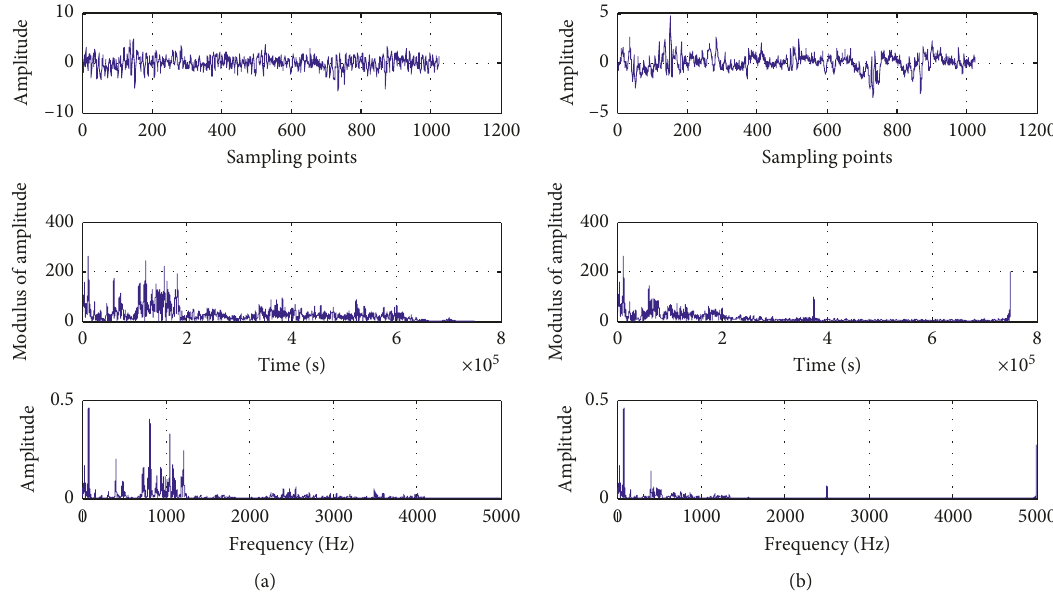
Figure 16: (a) Rolling wear signal, rolling wear Fourier transform, and power spectral density plot; (b) denoising signal, Fourier transform, and power spectral density plot after improving threshold.